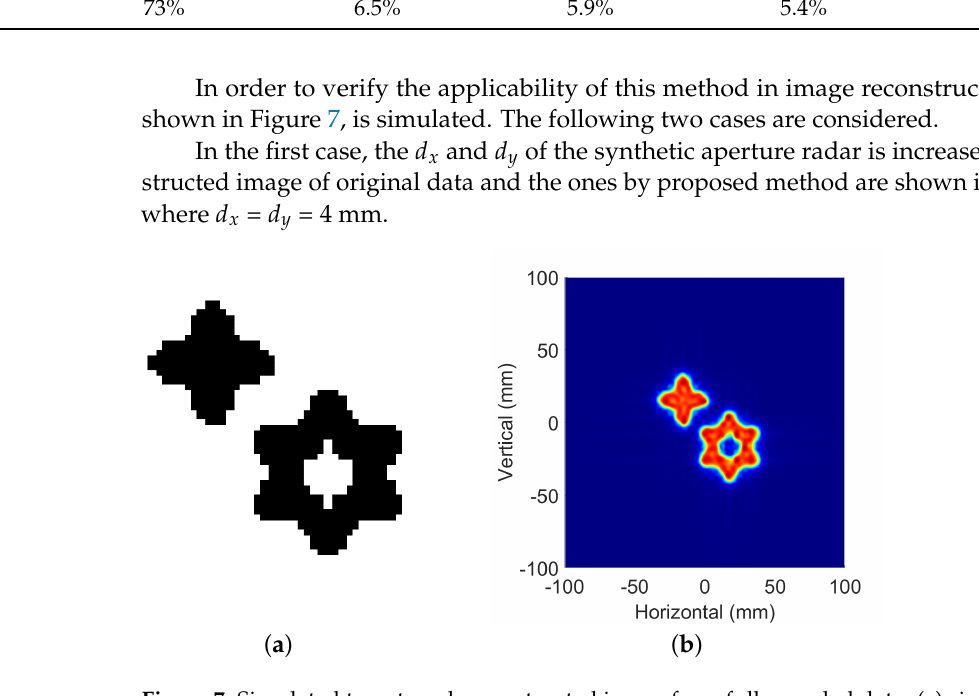
Figure 7. Simulated target and reconstructed image from full-sampled data: ( a ) simulation target; ( b ) reconstruction